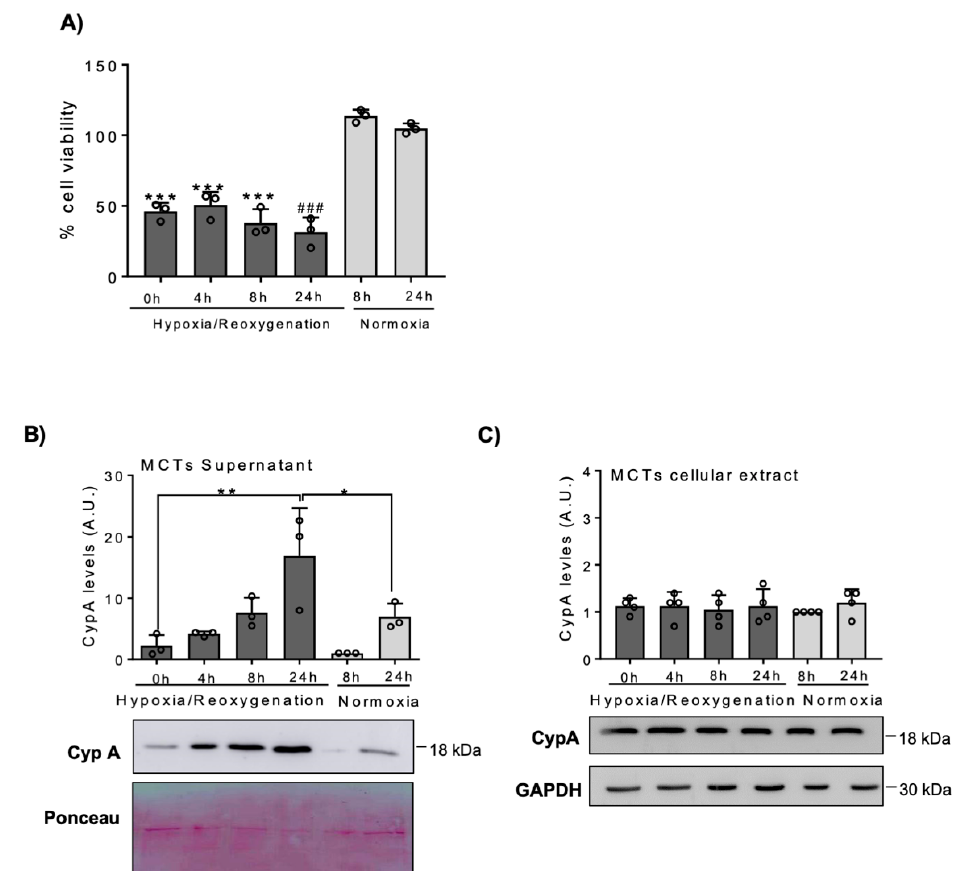
Figure 2. CypA is released by cultured murine proximal tubular MCT cells under hypoxia/reoxygenation. MCT cells were cultured for 24 h in a hypoxic atmosphere, and then cells were reoxygenated for the indicated periods of time ( A ) Cell viability was assessed by the MTT assay. Mean ± SD of three independent experiments. *** p < 0.001 vs. normoxia 8 h; ### p < 0.001 vs. normoxia 24 h. ( B , C ) Western blot of CypA in cell supernatants ( B ) and in cellular extracts ( C ). Quantification and representative image. Mean ± SD of three independent experiments. * p < 0.05; ** p < 0.01. Uncropped gel scans shown in Figure S1B.